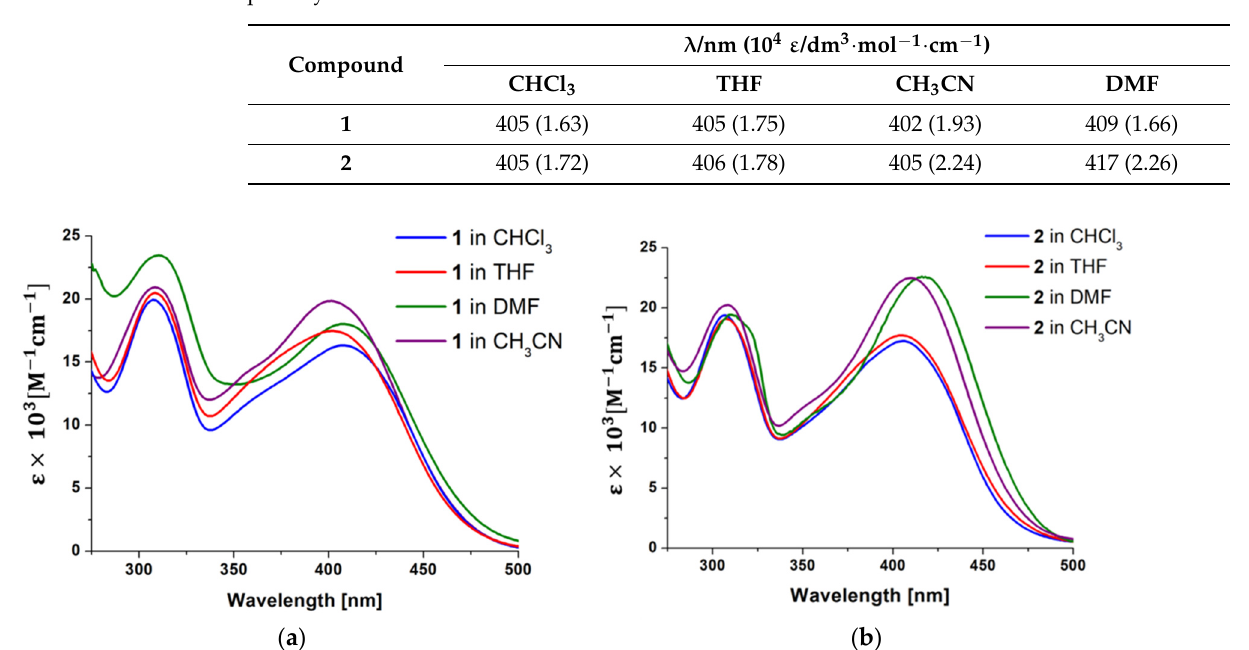
Table 1. The absorption maxima and molar extinction coefficient for 1 and 2 in solvents of different polarity.